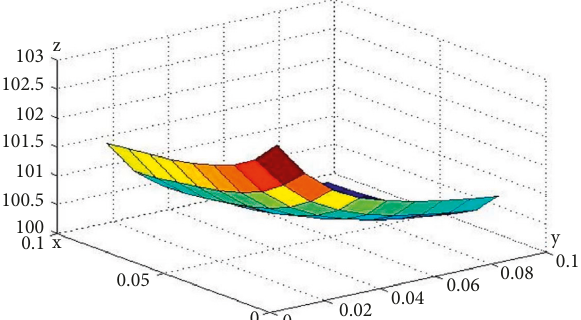
Figure 5: Changes in the expected loss with E figure, x axis denotes the losses reduced per unit funding invested in data ( E ), y axis denotes the losses reduced per unit funding 1 invested in application software ( E pected loss of smart